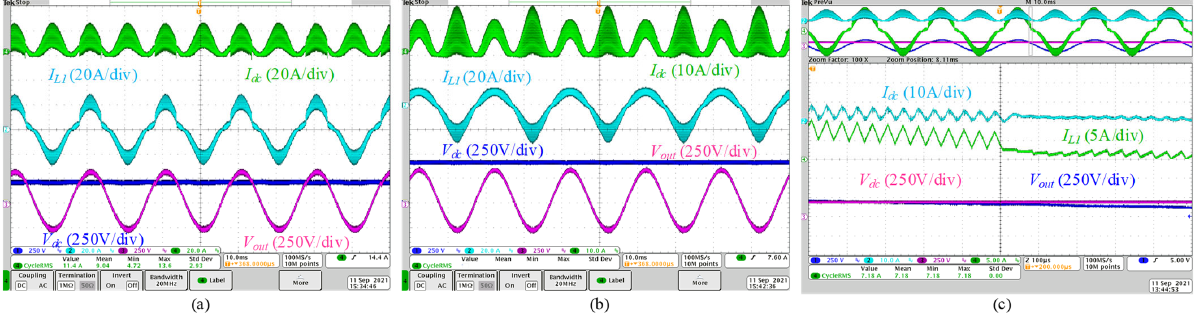
I , V dc , and V OUT from top to , V dc , and V OUT from top to 1 L 1